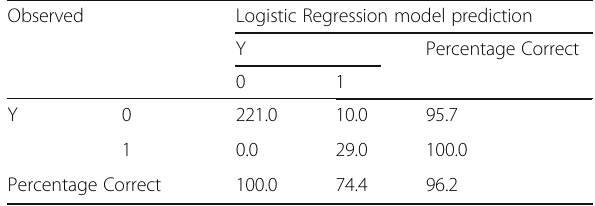
Table 10 Comparison result of diagnostic analysis degree of injury using Logistic Regression (LR) Observed Logistic Regression model prediction